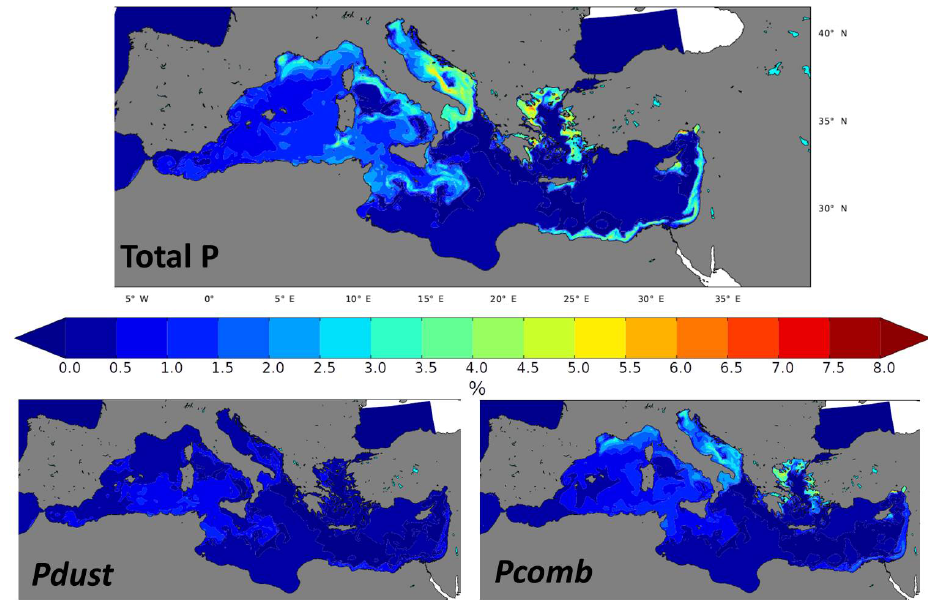
Figure 10. Average relative effects of total P, Pdust and Pcomb deposition on surface (0–10m) chlorophyll a concentration for June 2005. There is no atmospheric deposition modeled in the Marmara and Black